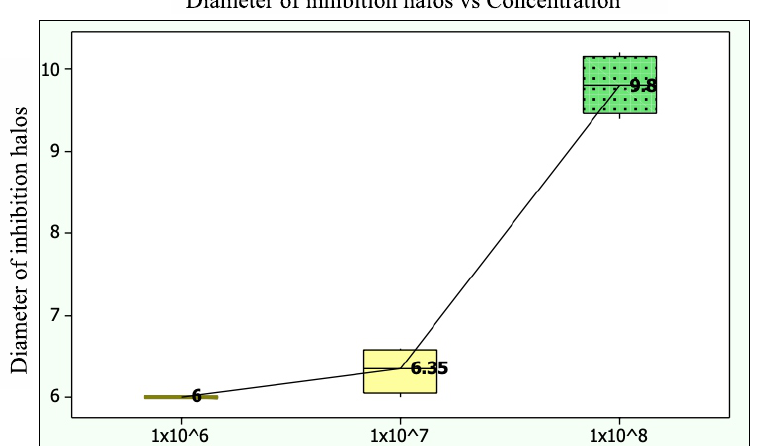
Fig. 1. Box plot of inhibition halos diameter vs the concentration of Lactobacillus acidophilus carried out in MINITAB